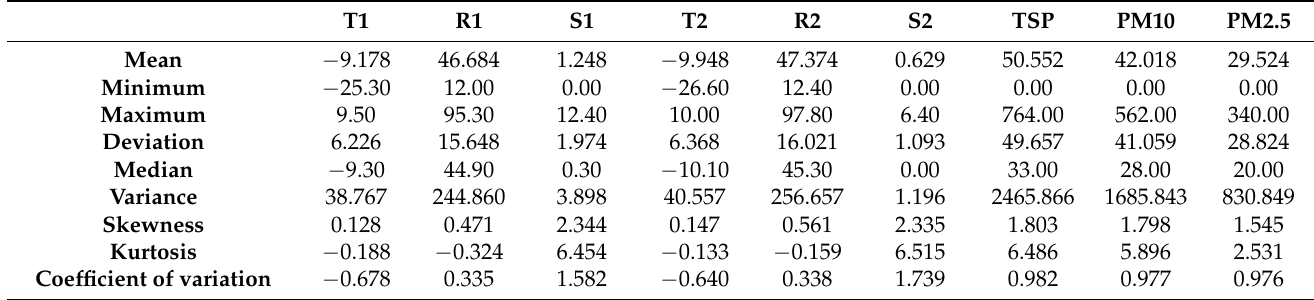
Table 2. Statistics of monitoring